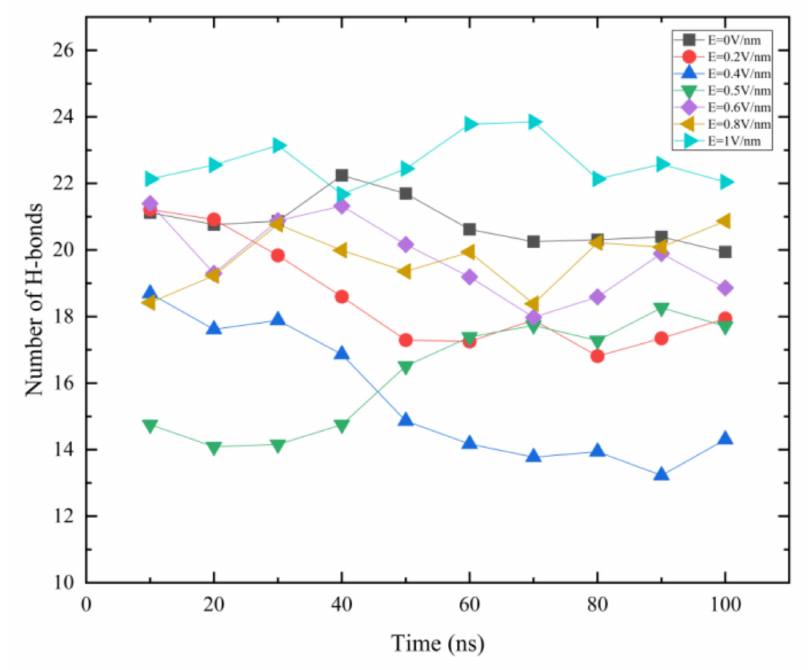
Figure 8. (Color online) Time evolution of hydrogen bonds are shown as a function of time in 100 ns. There are 10 points on each line due to the average of each 10 ns. The symbol coding scheme is as follows: E = 0 V/nm (black line), E = 0.2 V/nm (red line), E = 0.4 V/nm (blue line), E = 0.5 V/nm (green line), E = 0.6 V/nm (purple line), E = 0.8 V/nm (yellow line), E = 1 V/nm (cyan